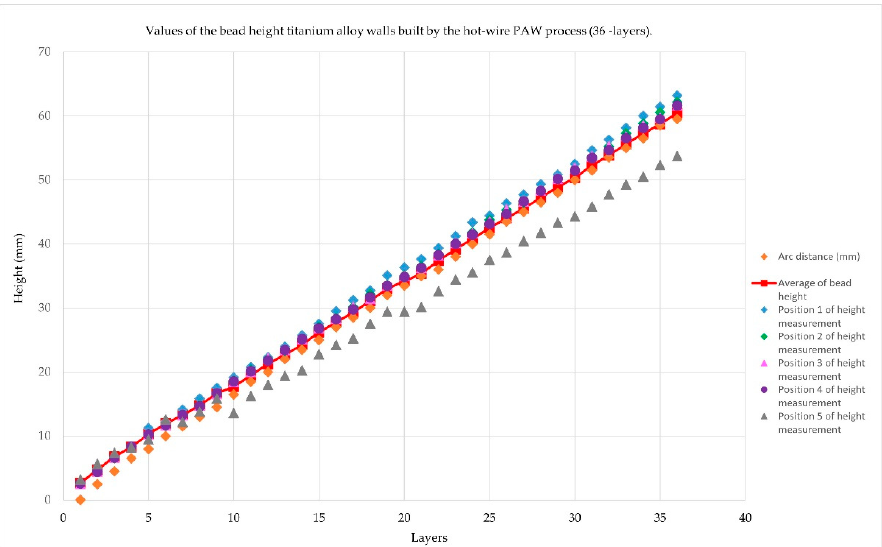
Figure 11. Values of the bead height titanium alloy walls built by the hot-wire PAW process (36- layers).